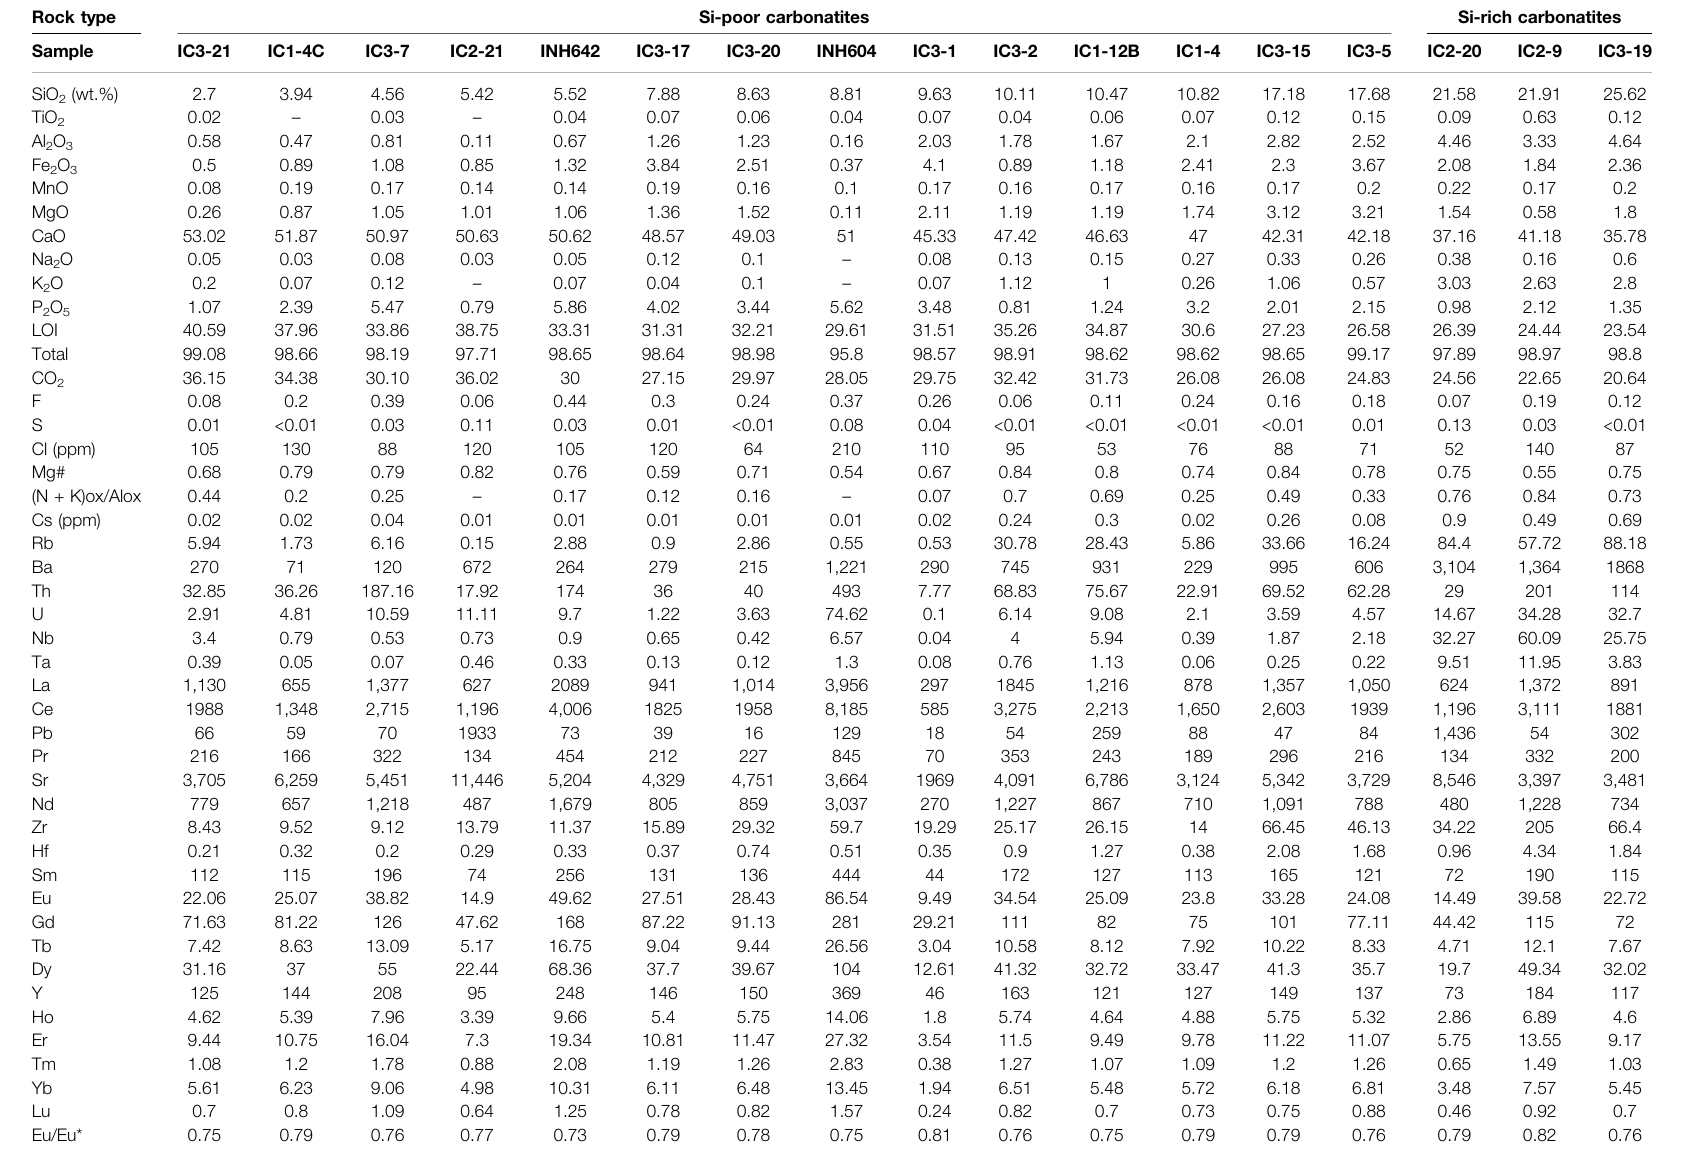
TABLE 1 | Representative major and trace element whole-rock compositions of carbonatites and syenites. Rock